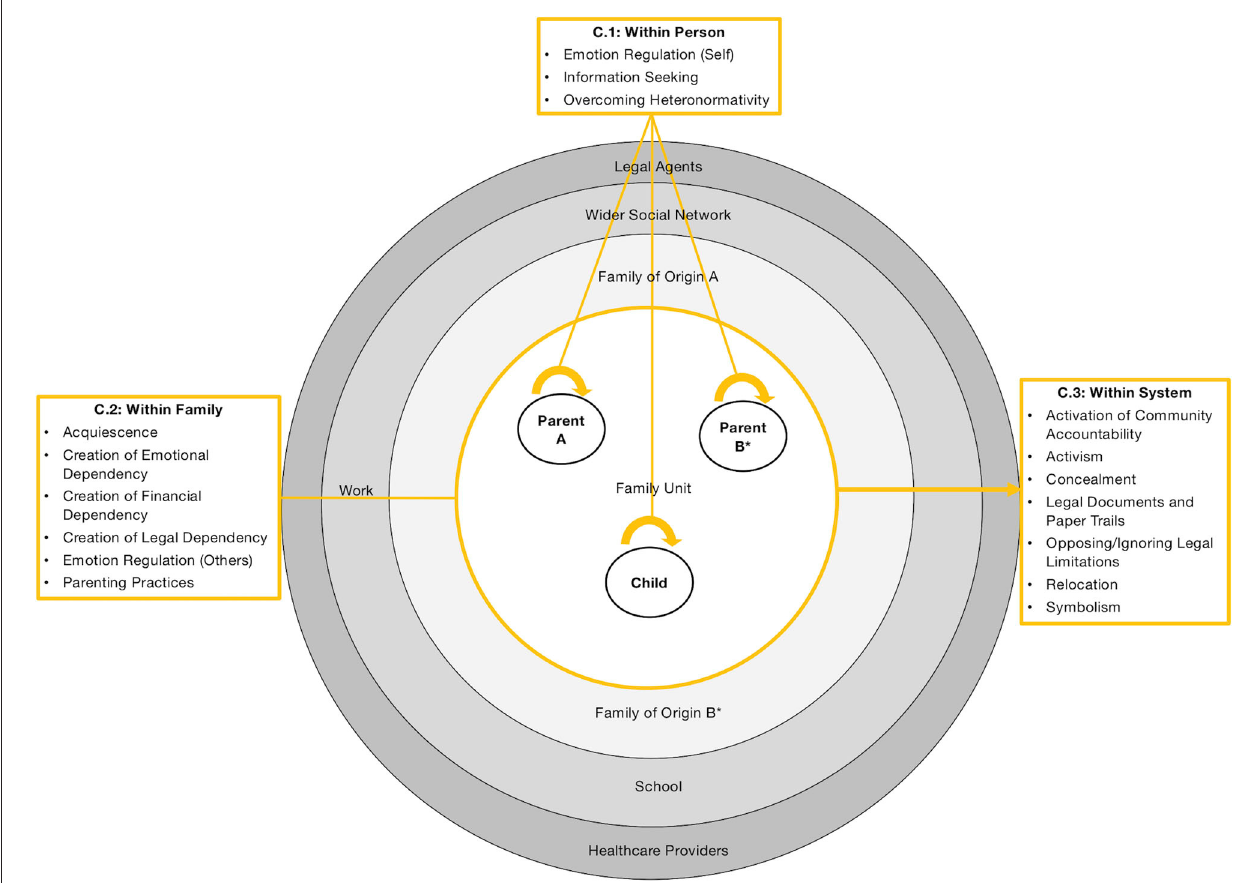
FIGURE 5 | Counteractions to alleviate the impact of legal vulnerability on the personal, familial, and systemic level. *Nonlegal status to child and/or